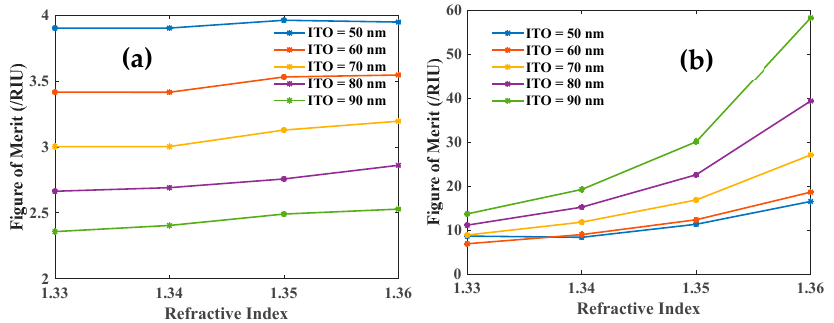
Figure 11. FOM of the ( a ) first LMR and ( b ) SPR dip with the variation of the third ITO layer thickness where the first layer is ITO (10 nm) and the second layer is Ag (10 nm).